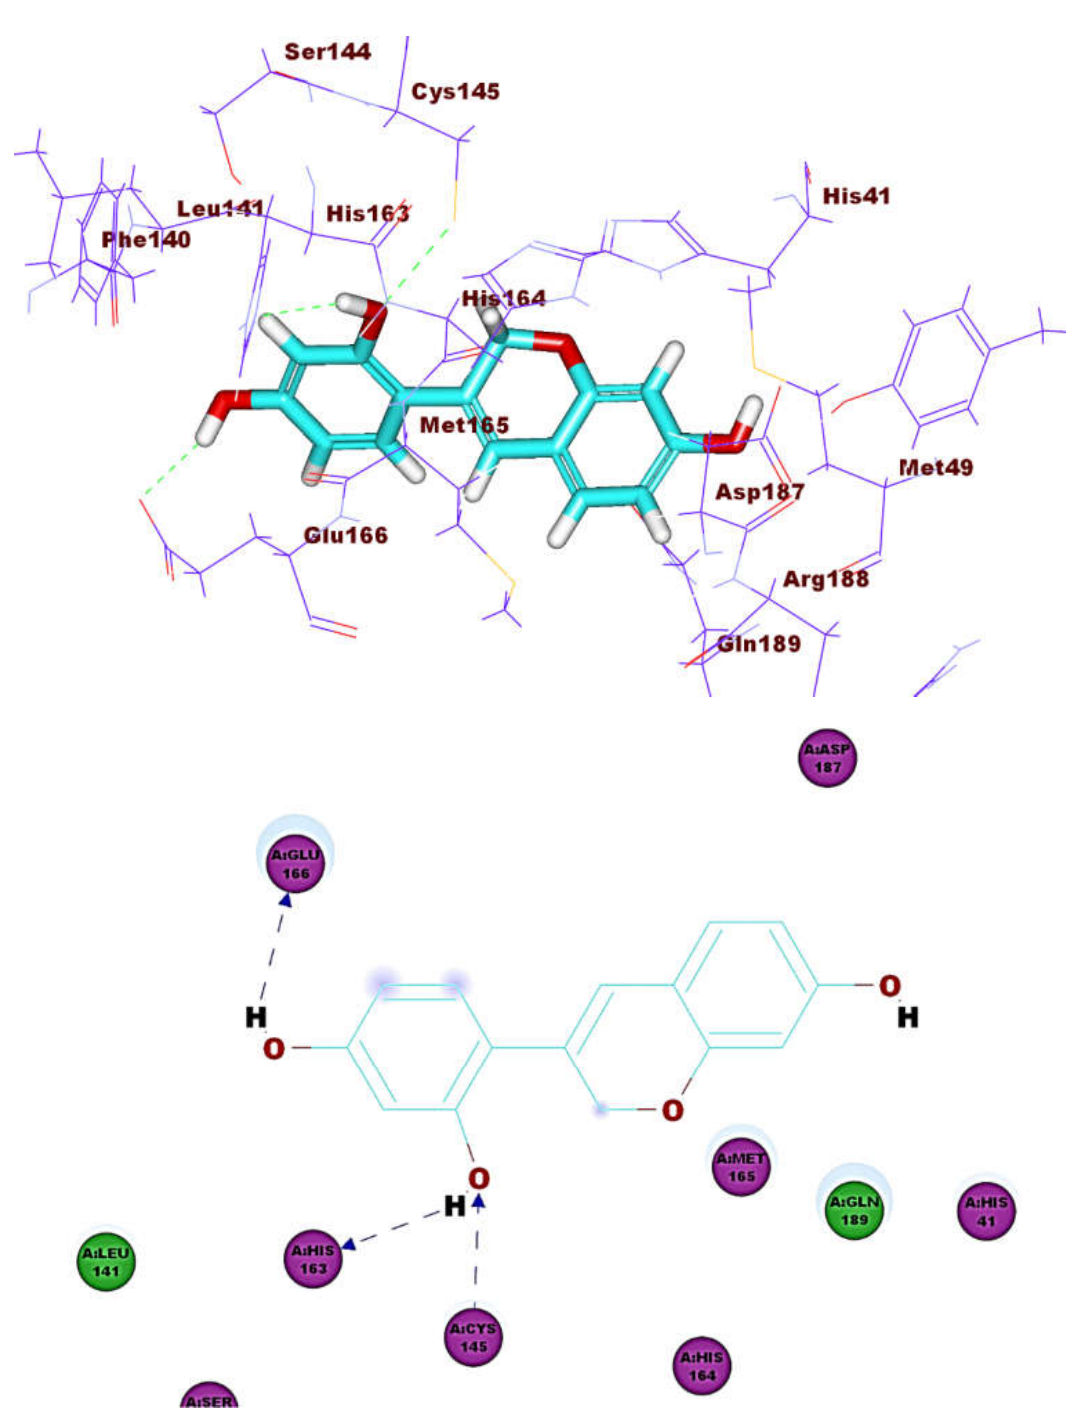
Figure 12. Compound 8 docked into M pro , forming three H. bonds with Glu166, Cys145 and His163.